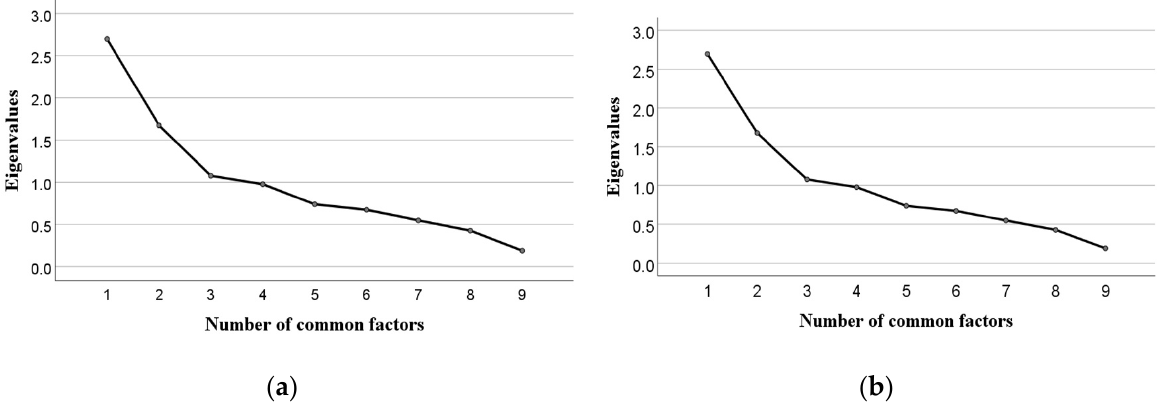
Figure 1. Scree plots. ( a ) Scree plot of oil-importing countries. ( b ) Scree plot of oil-exporting countries.